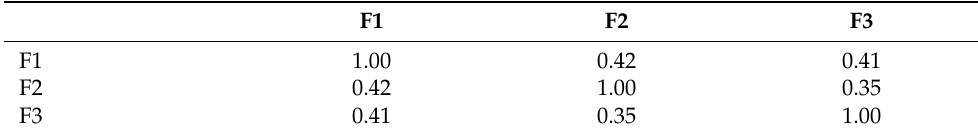
Table 5. Correlation between